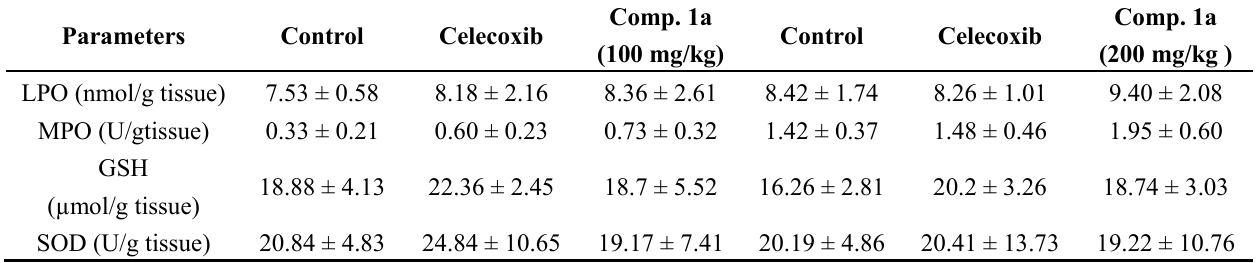
Table 6. Oxidative stress parameters in